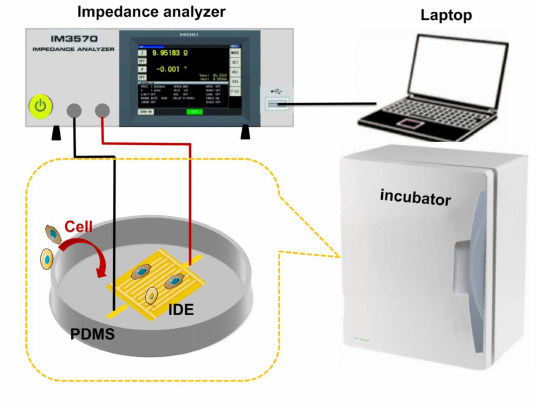
Figure 3. Schematics of impedance measurement of HeLa cells. HeLa cells were placed in the PDMS-enclosed well and then incubated at 37 ◦ C and 5% CO 2 . The impedance of the HeLa cells was monitored in real